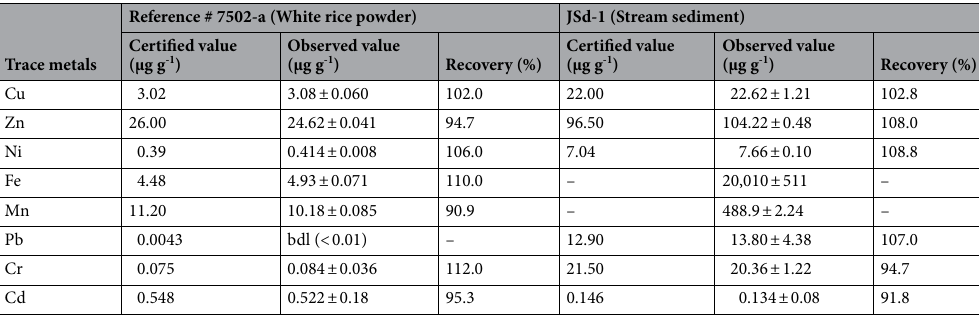
Table 1. Analytical results obtained for Certified Reference Material (CRM) samples along with per cent recovery. bdl below detectable limit.